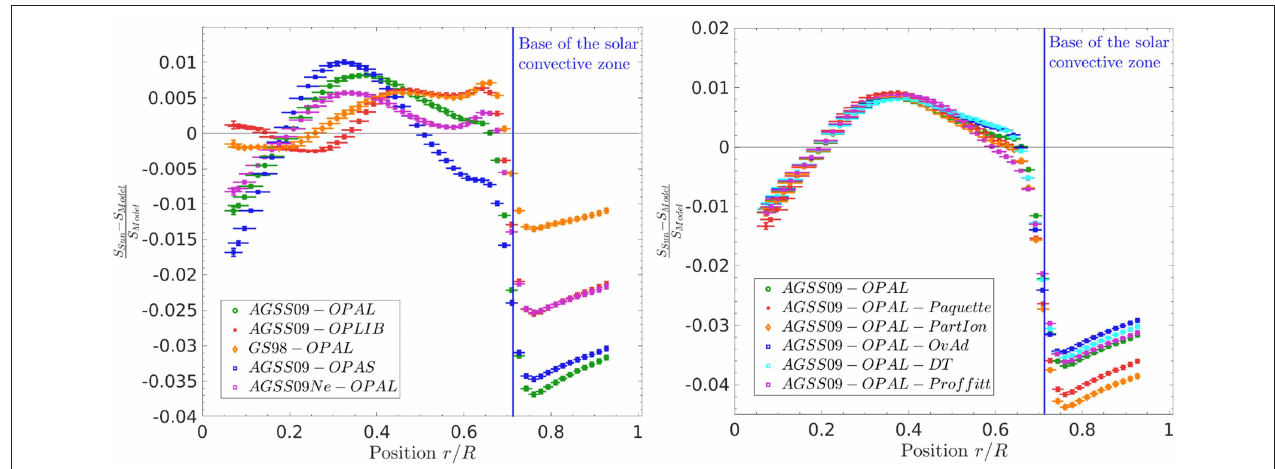
FIGURE 3 | (Left) Relative entropy proxy differences between standard solar models using various abundance and opacity tables and helioseismic results. (Right) relative entropy proxy differences between models including various prescriptions for the mixing of the chemical elements and helioseismic results.